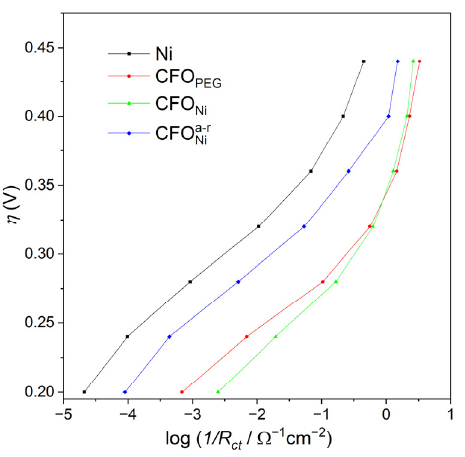
Figure 6. The electrical equivalent circuit used to describe oxygen evolution reaction on CoFe 2 O 4 electrodes.